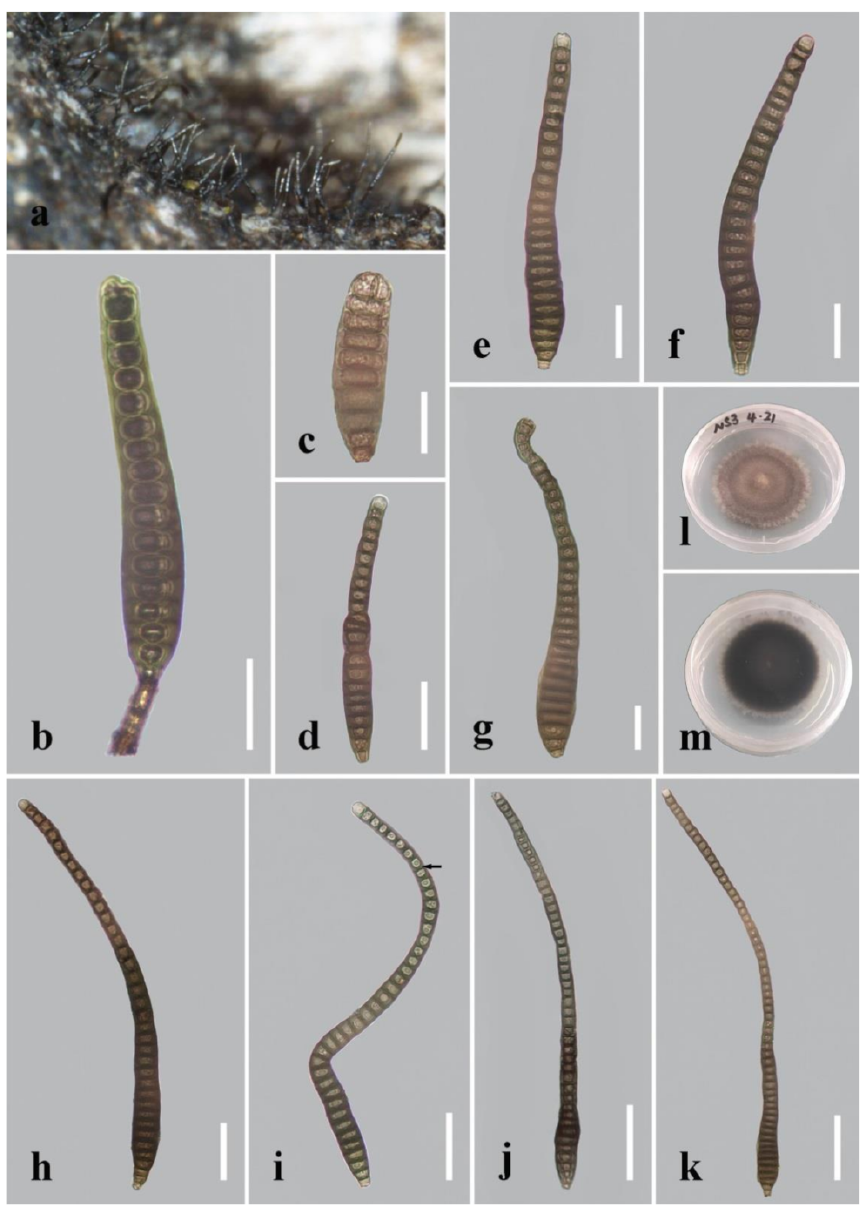
Figure 8. Distoseptispora curvularia (HKAS 122180, holotype). ( a ) Colonies on natural substrate. ( b ) Conidiophores with conidium. ( c – k ) Conidia. The arrow in i points to a gap in the middle of the septum, which indicates the distosepta. ( l ) Colony on PDA (from front). ( m ) Colony on PDA